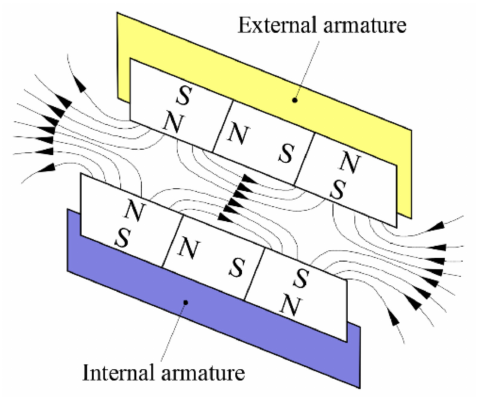
Figure 2. Schematic of the opposed Halbach